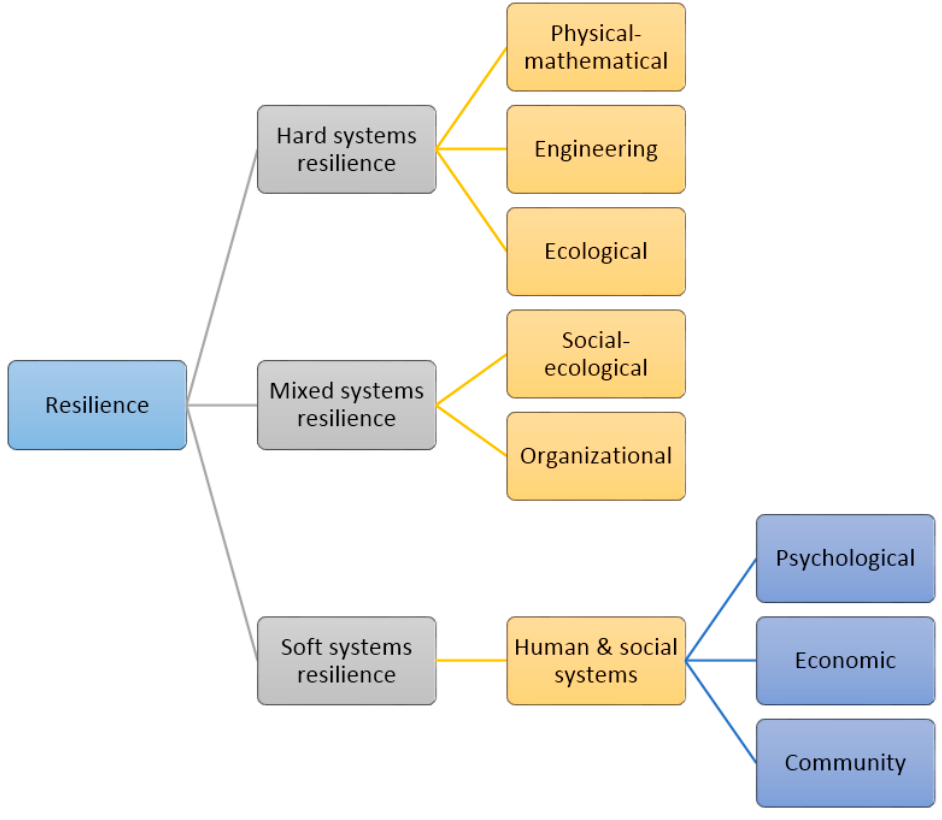
Figure 1. Major types of resilience (based on the nature of the system).